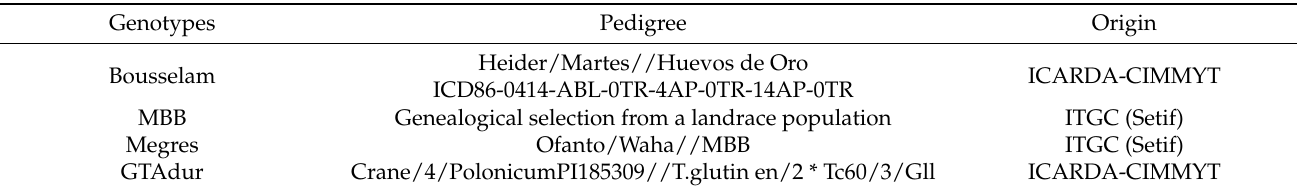
Table 2. Origin of the genotypes studied.